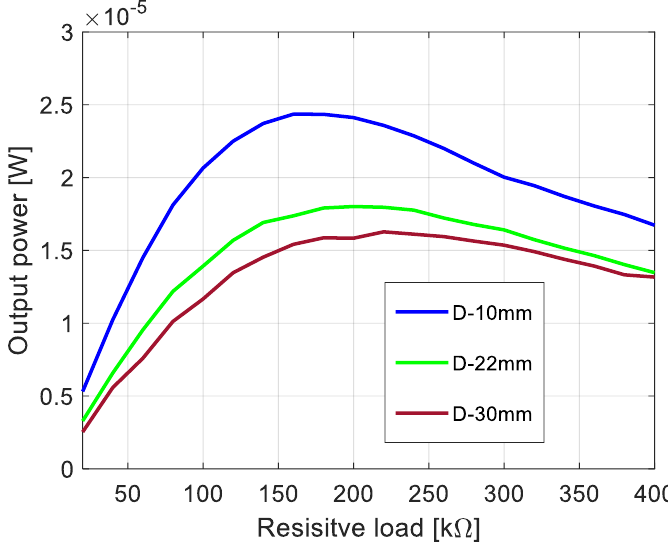
Figure 3. The comparison of the power output of the system for various distances between the